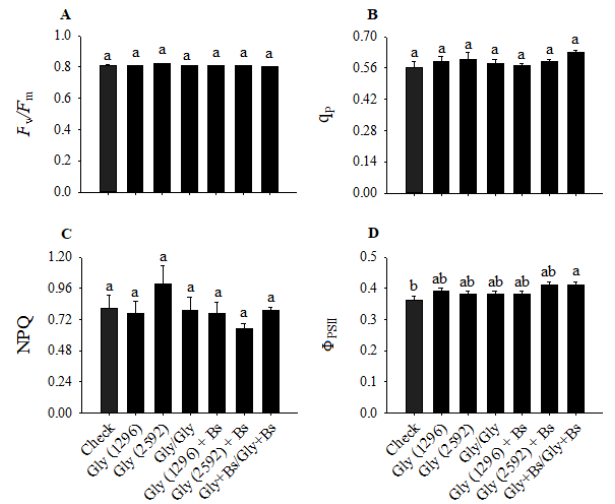
Figure 3. Chlorophyll a fluorescence parameters in plants submitted to different doses of glyphosate, with or without application of B. subtilis BV02. The following parameters were evaluated: potential quantum yield of photosystem II ( F v / F m – ( A )), the photochemical extinction coefficient (q P – ( B )), the non-photochemical quenching (NPQ – ( C )), and the effective quantum yield of photosystem II (ΦPSII– ( D )). Means followed by the same lowercase letters do not differ according to the SNK test ( p ≤ 0.05).